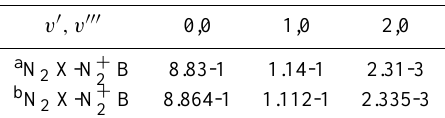
Table 3. Einstein coefficients from Gilmore et al. (1992) a , Lofthus et al. (1977) b , and Vallance Jones (1974) c